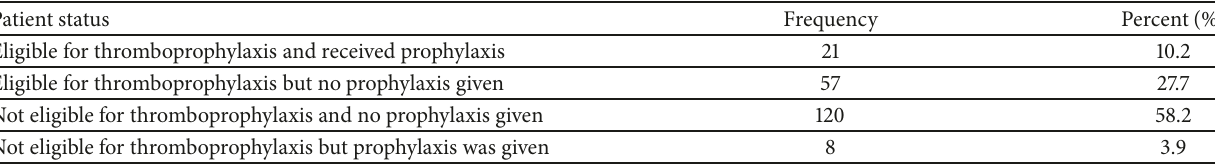
Table 4: Appropriateness of thromboprophylaxis use in medical wards of